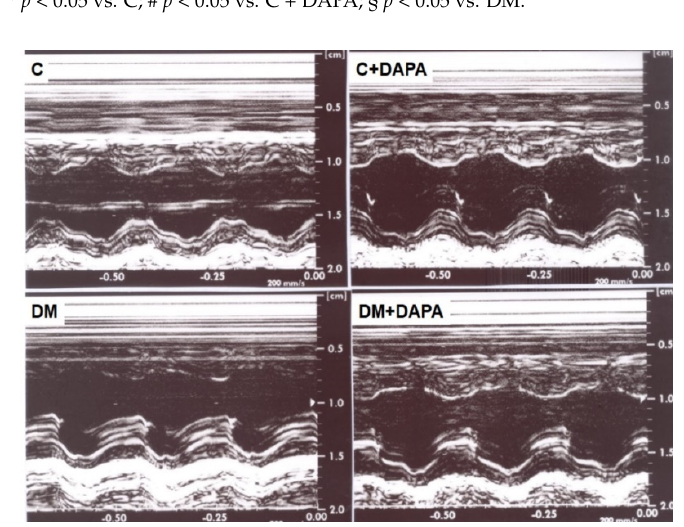
Figure 1. Illustrative left ventricle (LV) M − mode echocardiograms. C: control; C + DAPA: control